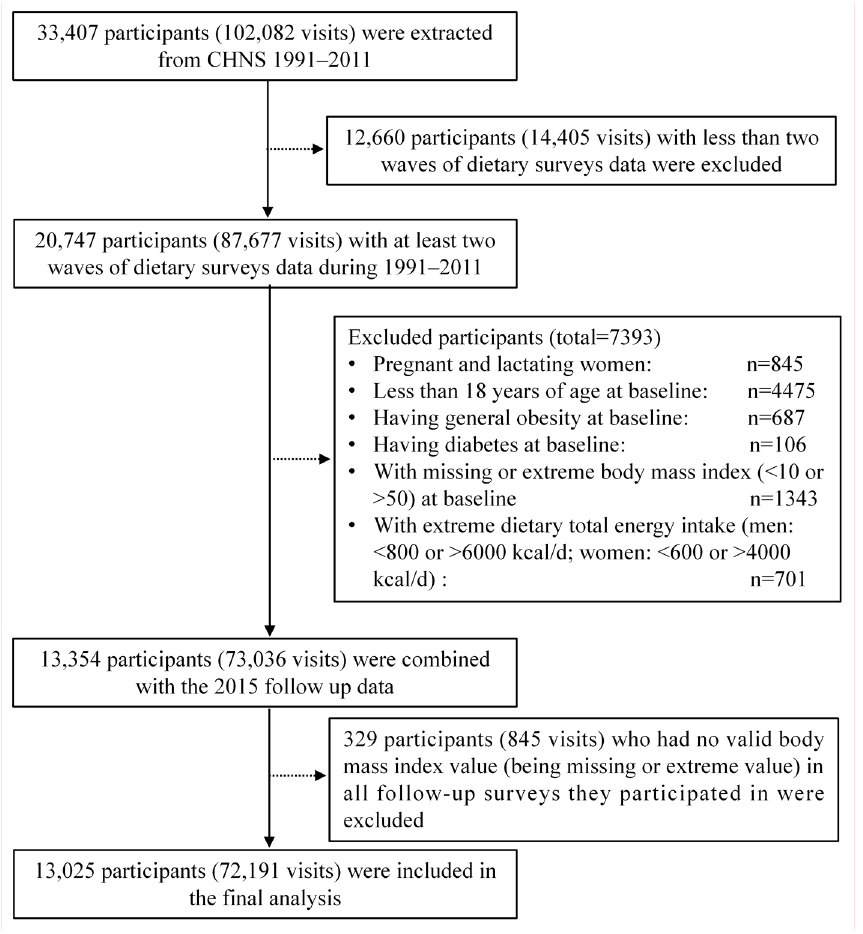
Figure 1. Flow diagram of participants in the study.